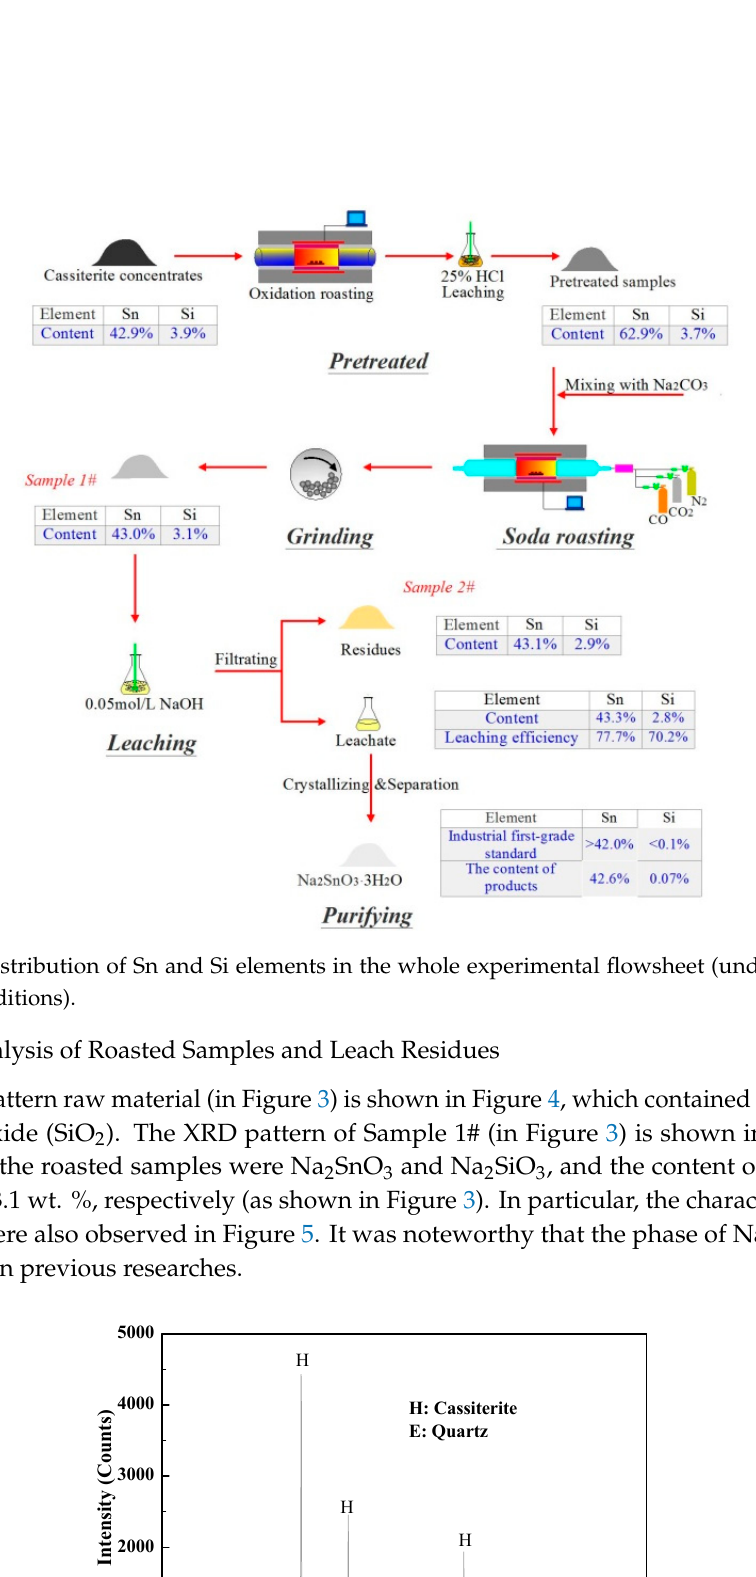
Figure 4. X-ray diffraction pattern of raw material.